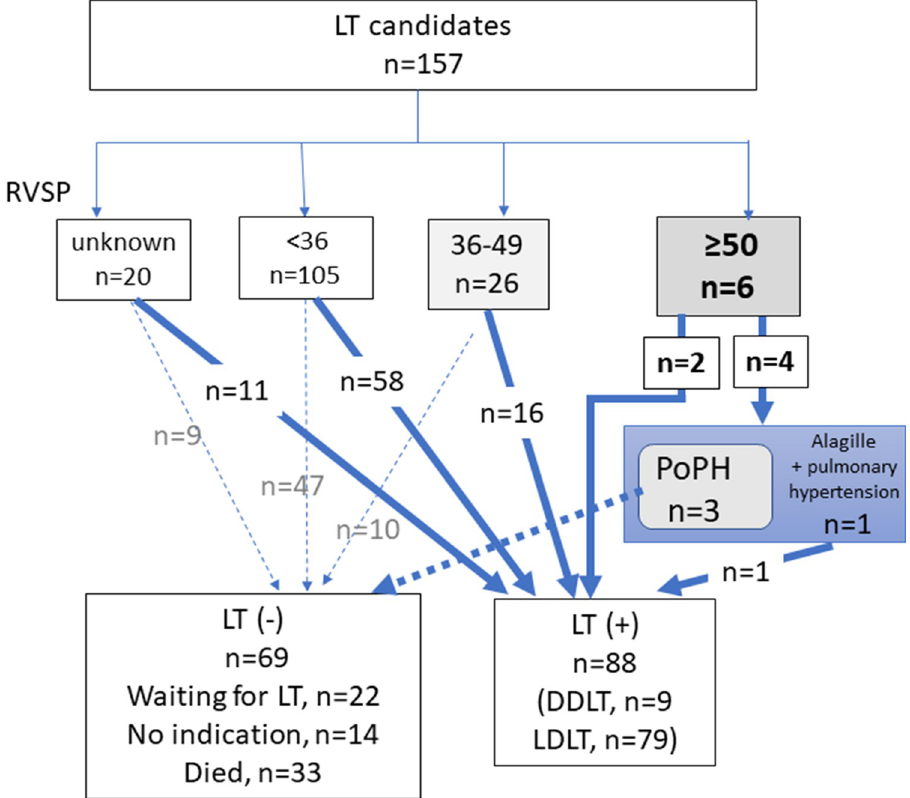
Fig 1. Flow-chart of the LT candidates. Overall, 157 patients underwent LT for end-stage liver disease. According to cardiography, 105, 26, and 6 cases had RVSPs of < 36, 36–49, and � 50 mmHg, respectively. LT was performed in 88 cases (9 cases of DDLT and 79 of LDLT). Three cases (1.9%) were diagnosed with PoPH. LT, liver transplantation; PAH, pulmonary arterial hypertension; PoPH, portopulmonary